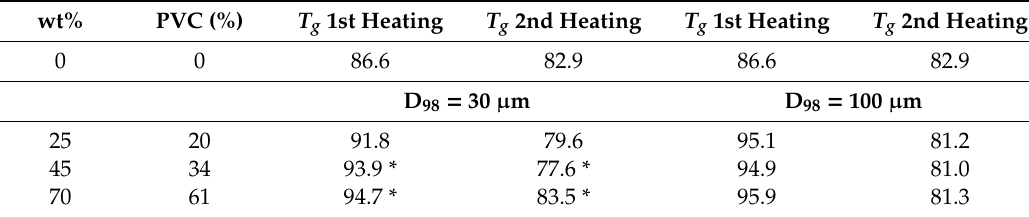
Figure 5. First heating ( a ) and Second heating scan ( b ) of the coatings prepared with feldspars of different particle sizes. Table 4. T g of the coatings estimated from 1st and 2nd DSC heating curves for samples with different loadings of feldspars with different particle sizes. PVC = pigment volume concentration based upon total formulation. * = average of two values.